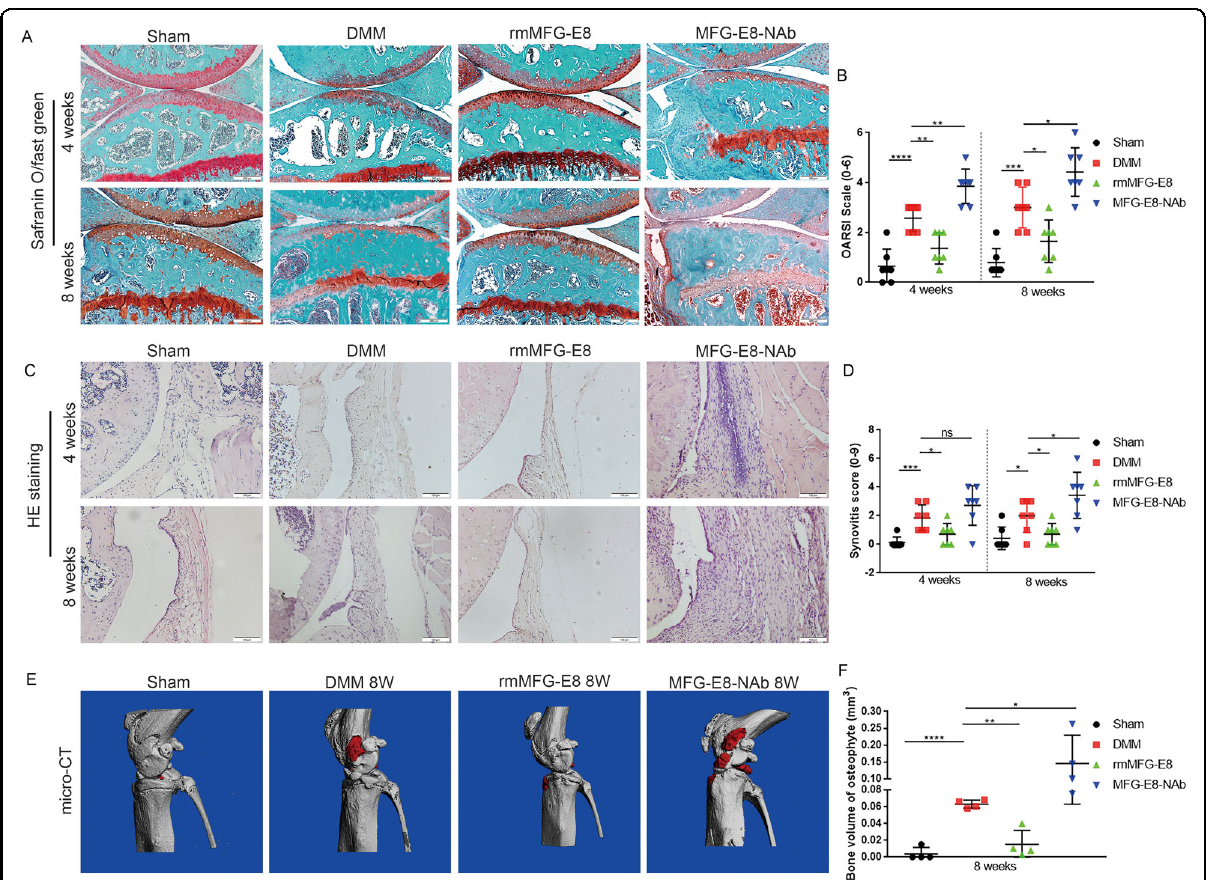
Fig. 2 MFG-E8 inhibition causes strikingly progressive articular cartilage loss, synovial hyperplasia, and massive osteophyte formation in OA mice. A Safranin O and Fast Green staining of knee cartilage from controls and DMM mice treated with vehicle, recombinant mouse MFG-E8 (rmMFG-E8) and MFG-E8 neutralizing antibody (MFG-E8-NAb) for 4 weeks and 8 weeks. Scale bar: 200 µm; B Osteoarthritis Research Society International (OARSI) grades for the joints described in A . n = 7 per group; C H&E staining of synovial tissues from controls and mice treated with vehicle, rmMFG-E8 and MFG-E8-NAb for 4 weeks and 8 weeks. Scale bar: 100 µm; D Synovitis score for the joints described in C . n = 7 per group; E Micro-CT scan and three-dimensional reconstruction of the knee joint from controls and mice treated with vehicle, rmMFG-E8, or MFG-E8-NAb for 8 weeks; F Bone volume of osteophytes of the knee joints described in E . n = 4 per group. * P < 0.05, ** P < 0.01, *** P < 0.001, **** P < 0.0001, ns not signi fi